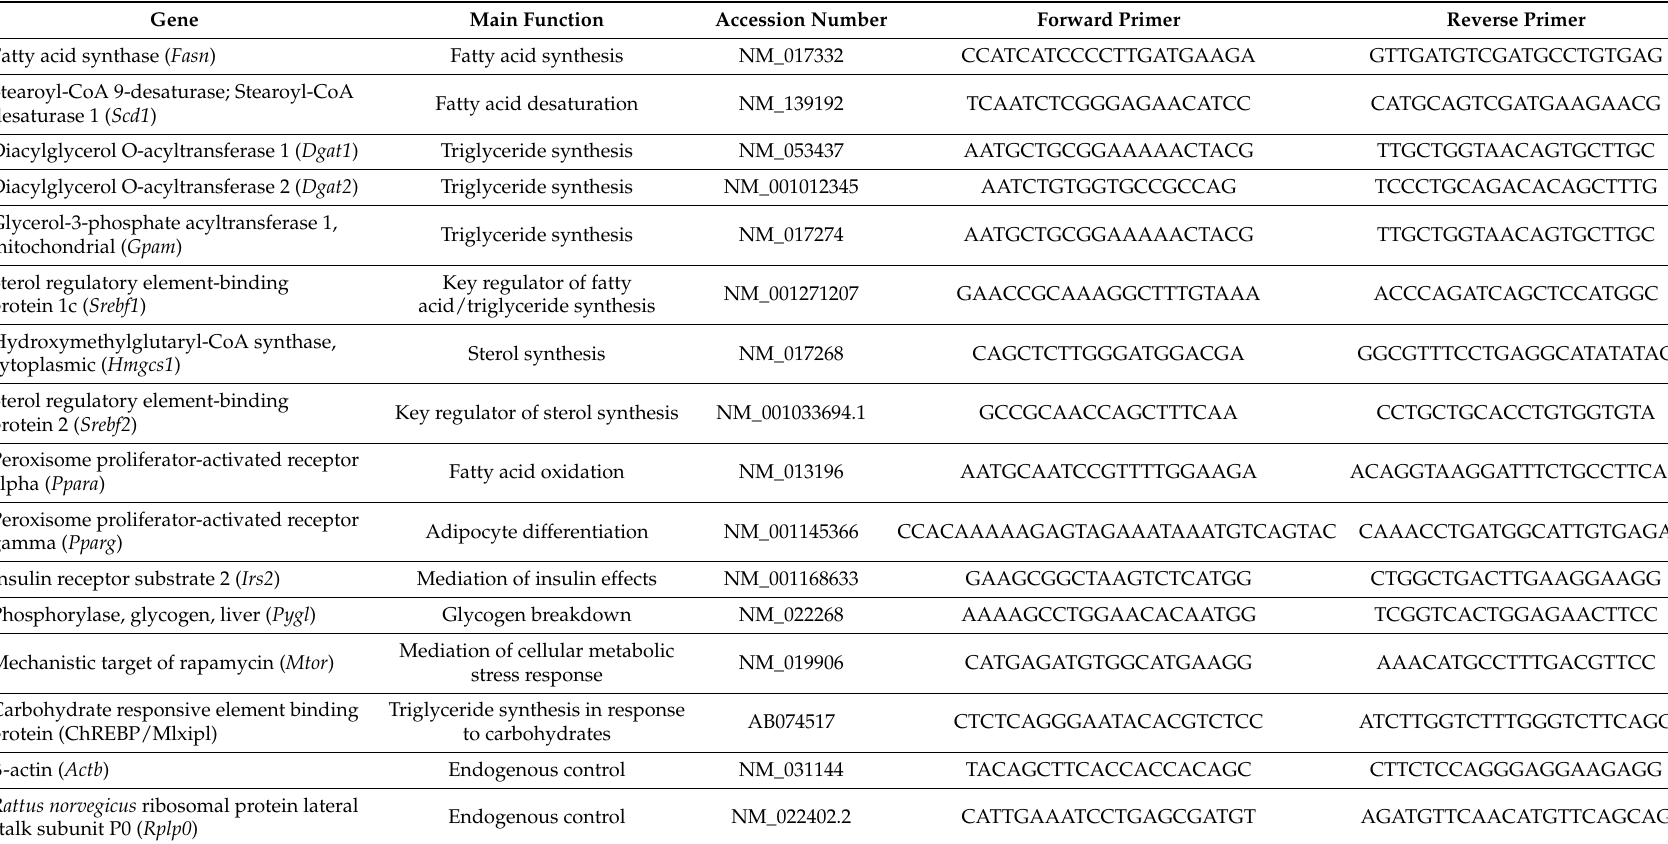
Table 1. Sequence names, accession numbers, and primer sequences for genes examined for hepatic transcriptional